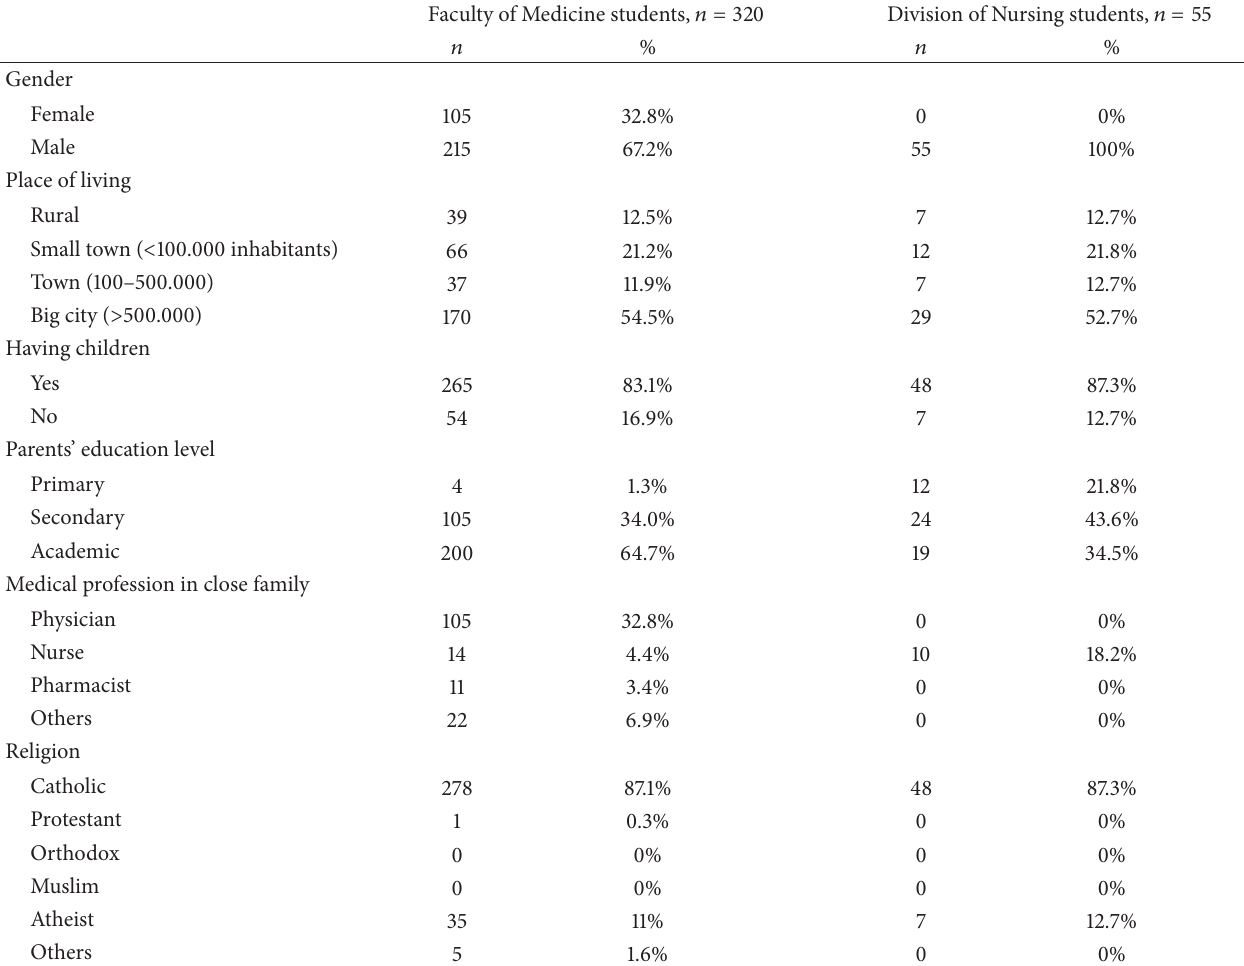
Table 1: Social and demographic characteristics of